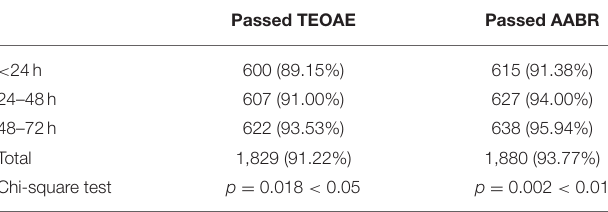
TABLE 3 | The pass rates (n/%) of first TEOAE and AABR screening in 2005 neonates as a function of age.